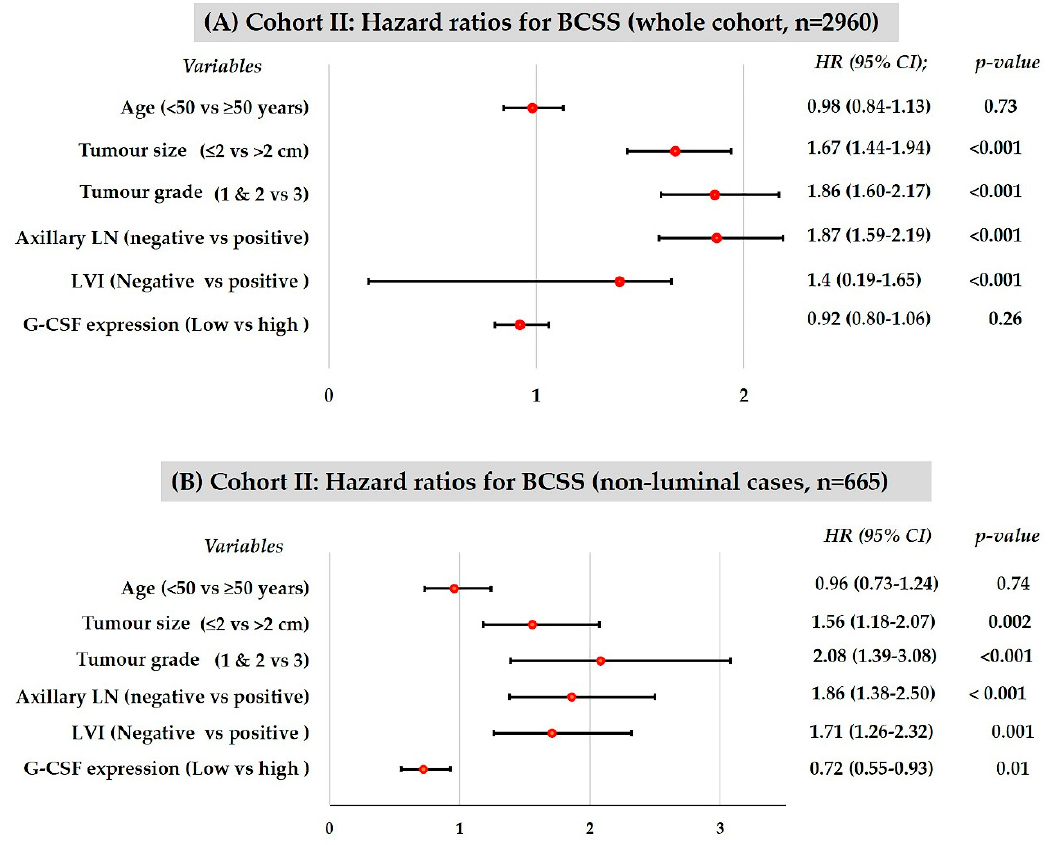
Figure 3. Cohort II: Forest plots based on the results of multivariable analysis for risk factors associated with breast cancer-specific survival in whole series ( A ) and in non-luminal cases ( B ).